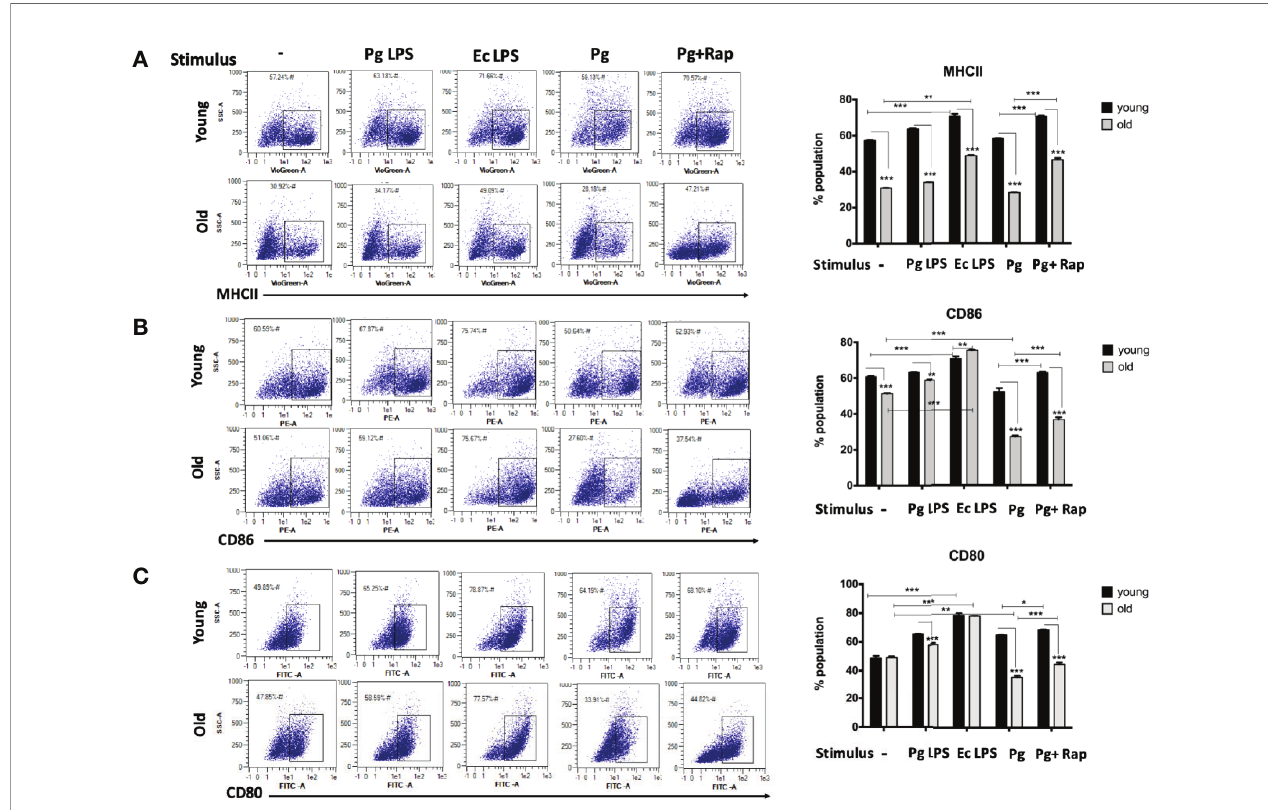
FIGURE 2 | P.gingivalis impairs maturation of bone marrow derived dendritic cells(DCs) from young and old mice. At day 6, DCs from young (yDCs) and old (oDCs) mice were co-cultured with P.gingivalis (10 MOI) ± Rapamycin (1µM), Pg LPS (100ng/ml) or Ecoli LPS (100ng/ml). Cells were harvested at day 8 and analyzed by fl ow cytometry for the expression of maturation markers, MHCII and co stimulatory molecules CD80 and CD86. (A) Flow cytometry scatter gram and its corresponding bar graph showing % of MHCII positive cells in young (upper panel) and old (lower panel), DCs gated on CD11c + cells (gate not shown). (B) Flow cytometry scatter gram and its corresponding bar graph showing % of CD86 positive cells in young (upper panel) and old (lower panel), DCs gated on CD11c + cells (gate not shown). (C) Flow cytometry scatter gram and its corresponding bar graph showing % of CD80 positive cells in young (upper panel) and old (lower panel), DCs gated on CD11c + cells (gate not shown). Analysis was done using Two-way ANOVA and Dunn ’ s correction test. (Data are expressed as means ± SD, *p<0.05, **p<0.01, ***p<0.001). NS, not signi fi